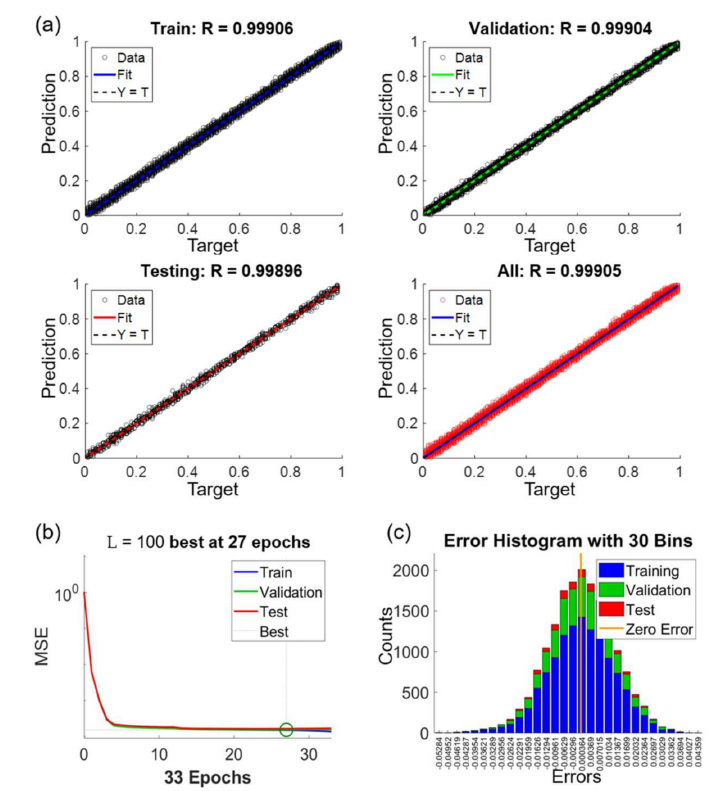
Figure 11. The performance of the network training for L = 100, N H = 20 and θ = 15 ◦ . ( a ) Regression plots with different data sets. ( b ) Convergence of training. ( c ) Error histogram of the